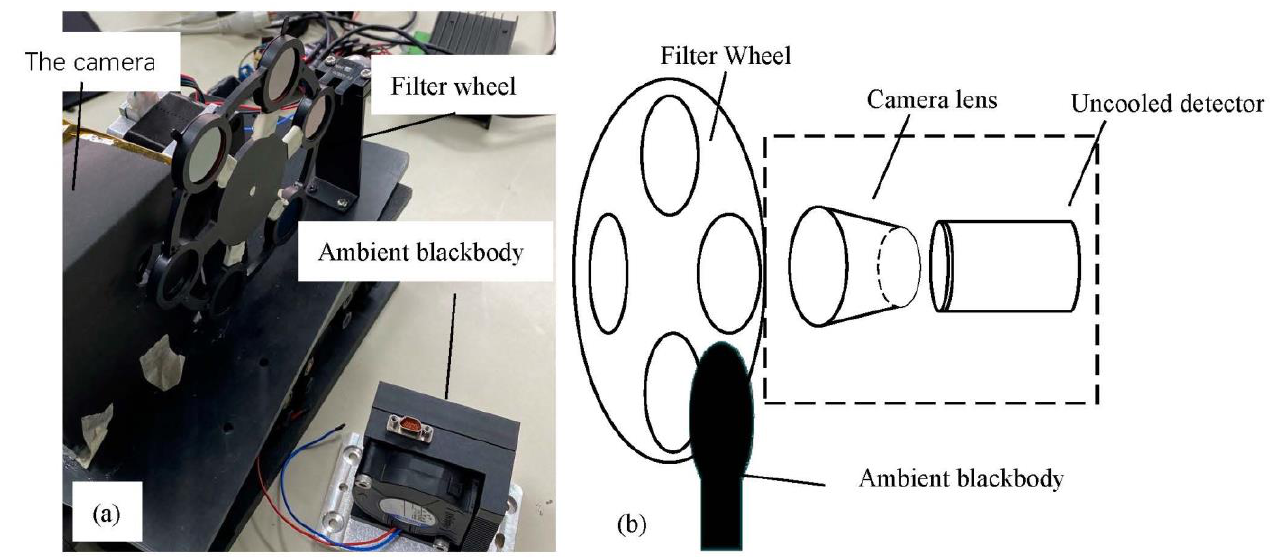
Figure 2. ( a ) The multi-spectral camera setup. ( b ) System structure prototype when working.